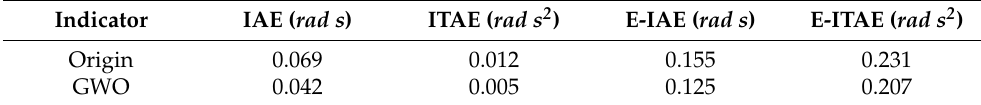
Table 5. Performance of the optimised roll sub-controller.